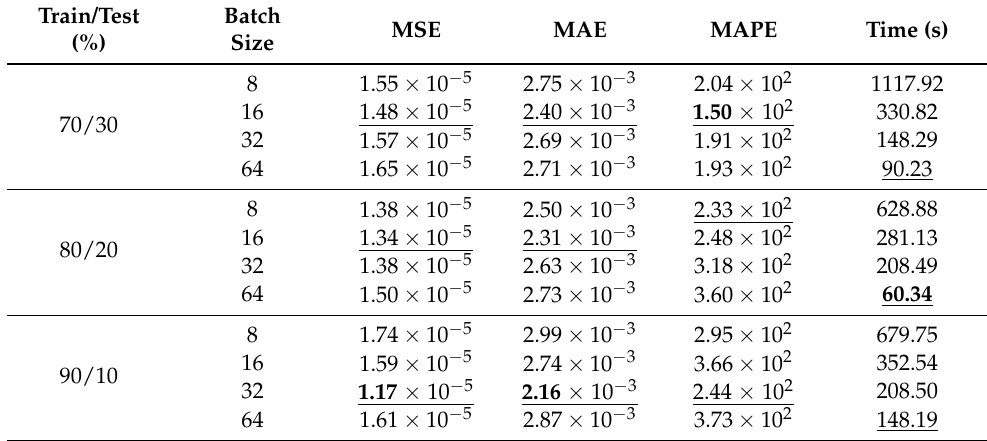
Table 3. Assessment of the influence of how the dataset is